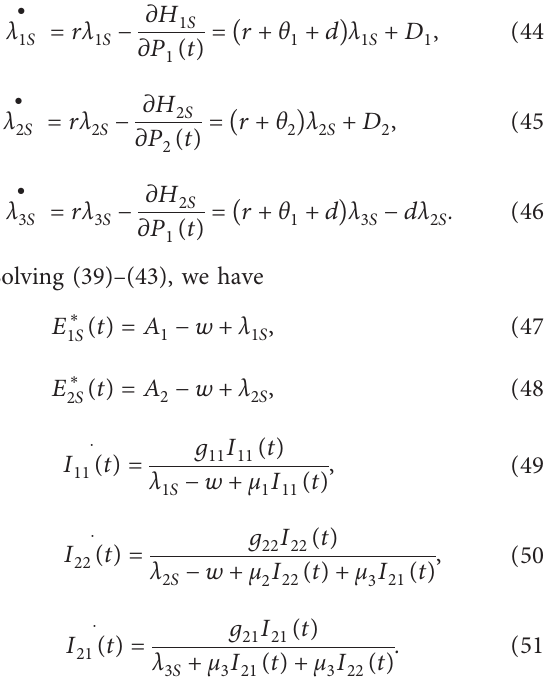
and downstream P 1